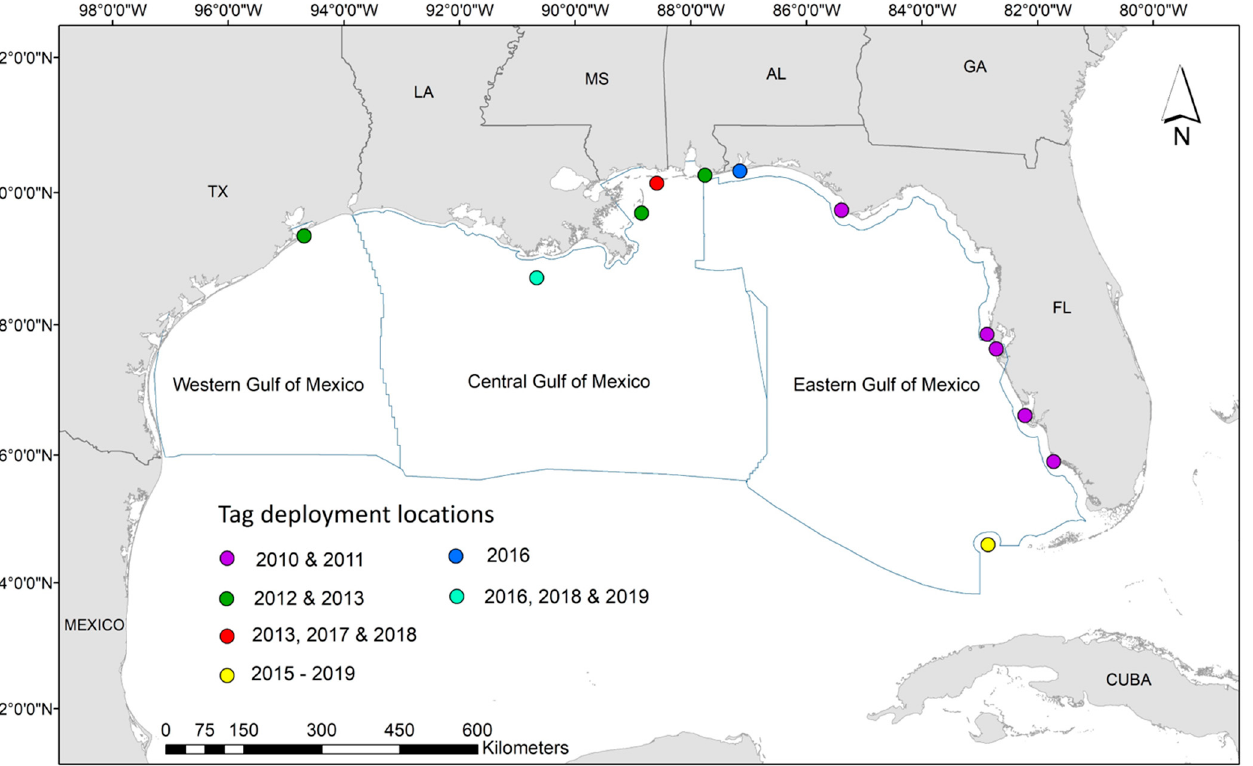
Figure 1. Map of study area and tag deployment locations, from 2010 to 2019, for all 136 turtles included in this study. Sub regions of the Gulf of Mexico as defined by Bureau of Ocean Energy Management (BOEM), from which descriptive and statistical analyses were performed, are outlined in blue.